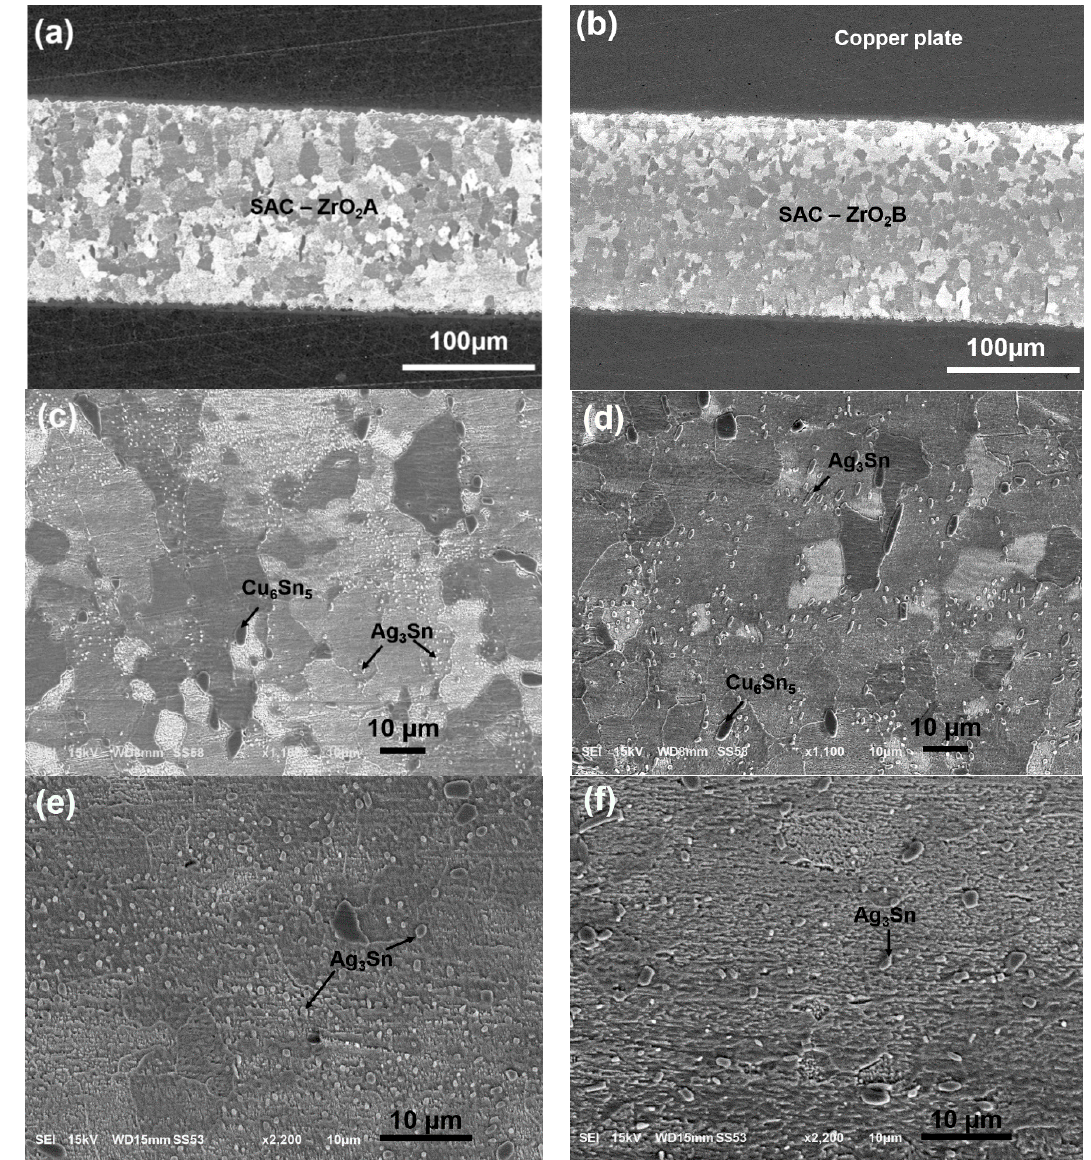
Figure 8. ( a – d ) SEM micrograph of 48 h isothermally aged joints. ( a ) SAC 305-ZrO 2 A/Cu joint and ( c ) the corresponding microstructure, ( b ) SAC 305-ZrO 2 B/Cu joint and ( d ) the corresponding microstructure. ( e ) and ( f ) microstructure of 256 h isothermally aged SAC 305-ZrO 2 A/Cu joint and SAC 305-ZrO 2 B/Cu joints respectively .